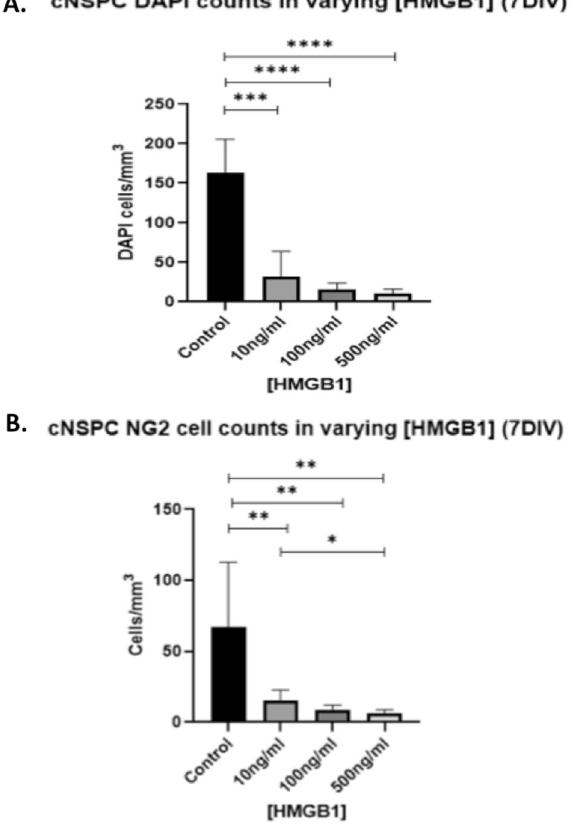
Figure 3. Disulfide HMGB1 reduces overall cell and NG2 + cell counts in vitro. ( A ) Addition of disulfide HMGB1 at concentrations of 10 ng/ml, 100 ng/ml and 500 ng/ml significantly reduced overall cell counts compared to control conditions. ( B ) Disulfide HMGB1 significantly reduced NG2 + cell counts in all experimental conditions, in a dose dependant manner. For multiple different conditions, a two ‐ way ANOVA and one-way ANOVA with Dunnett’s multiple comparison test was used. p values of < 0.05 were considered significant (* p < 0.05; ** p < 0.01; *** p < 0.001; **** p < 0.0001). cNSPCs = rat cortical neural stem cell progenitors; DIV = days in